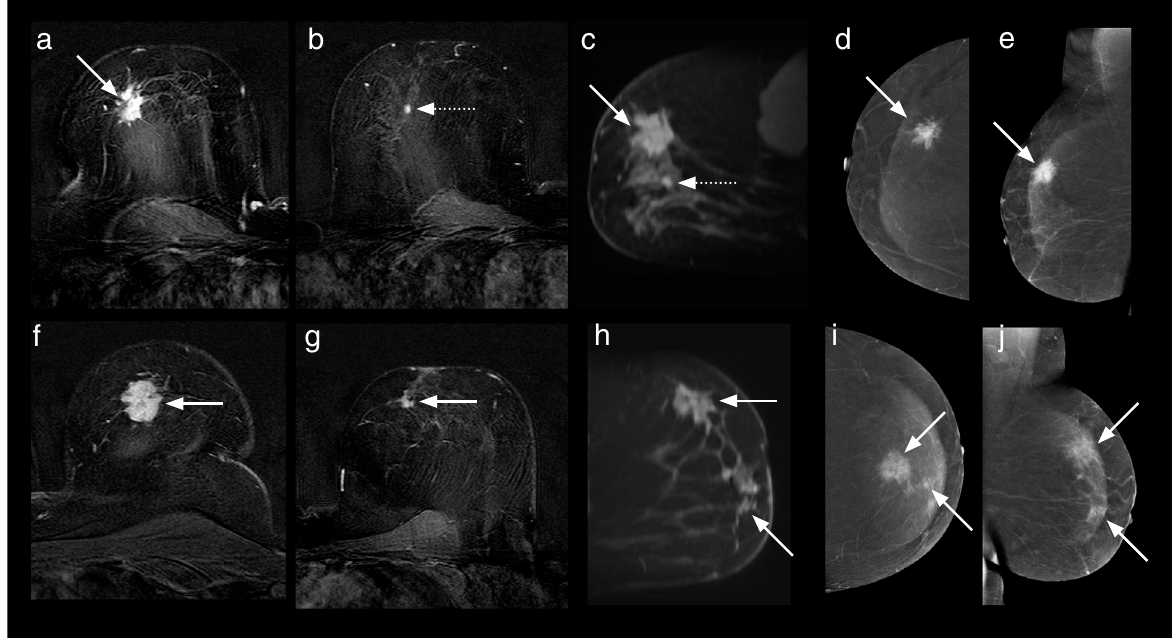
Fig. 6 Case number 4 of Table 3. A 57-year-old patient with bilateral lesions detected on screening mammography, one on the right (grade 2 infiltrating ductal carcinoma with intermediate grade DCIS) and two on the left (both grade 2 infiltrating ductal carcinomas with DCIS). Right breast: T1-weighted post-contrast axial ( a, b ) and sagittal ( c ) MRI images; recombined CC ( d ) and MLO ( e ) CEM images. Left breast: T1-weighted post-contrast axial ( f, g ) and sagittal ( h ) MRI images; recombined CC ( i ) and MLO ( j ) CEM images. Solid arrows point to the sites of the primary lesions initially detected on conventional imaging. An additional right-sided lesion (dotted arrows) was noted on the MRI, 18 mm inferior to the primary lesion. This lesion was not seen on CEM - it may have been superimposed on the main lesion on the CC view and contrast “wash-out” may have occurred by the time of MLO was acquired. Confirmation of additional lesion (a 7-mm invasive ductal carcinoma grade 2 with low grade DCIS) could have changed the treatment plan. CC Craniocaudal, CEM Contrast-enhanced mammography, DCIS Ductal carcinoma in situ , MLO Mediolateral, MRI Magnetic resonance